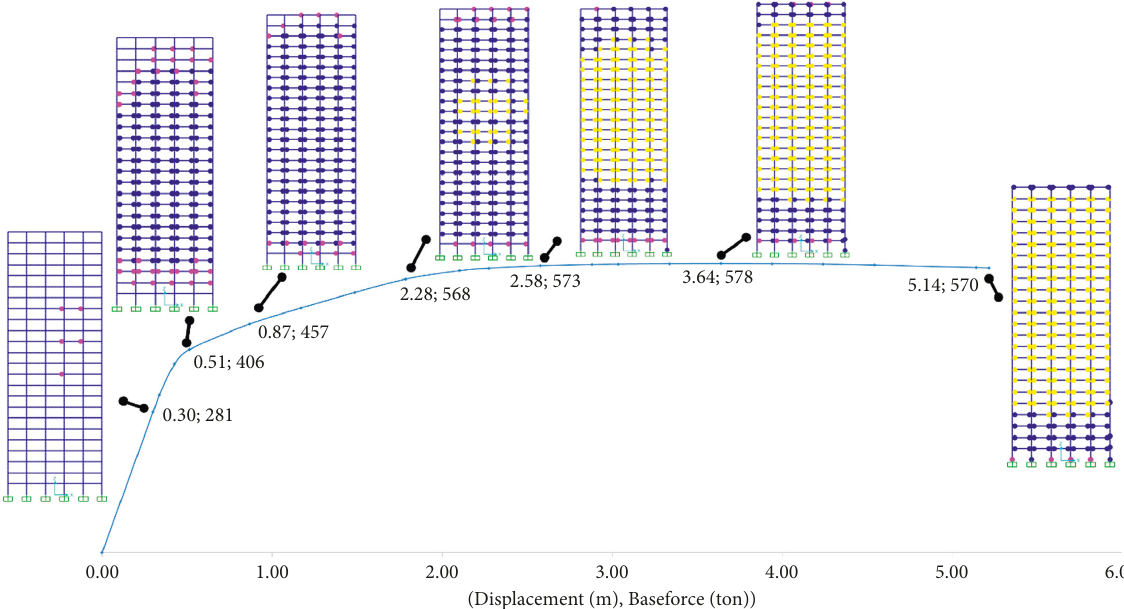
Figure 22: Push diagram of the 24-story frame designed by the energy method.